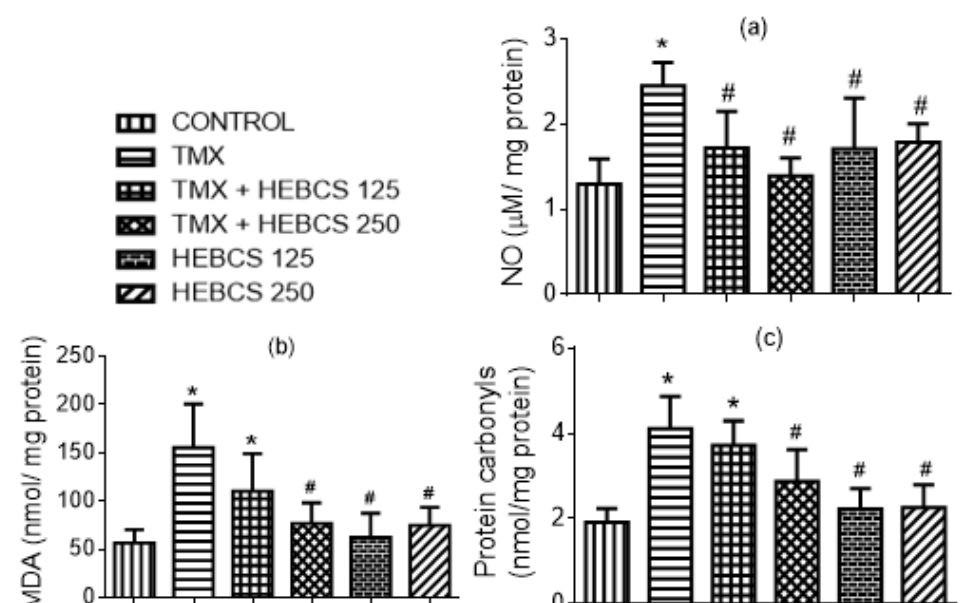
Figure 10. Ameliorative effect of HEBCS against TMX induced an increase in hepatic ( a ) NO level; ( b ) MDA level and ( c ) protein carbonyls level in rats. Data are presented as mean ± SD ( n = 6). * p < 0.05 Control versus other groups; # p < 0.05 TMX versus HEBCS groups. MDA: malondialdehyde; NO: nitric oxide; TMX: Tamoxifen; HEBCS 125 and 250: Hydroethanolic Extract of Buchholzia coriacea Seeds, 125 and 250 mg/kg body weight.